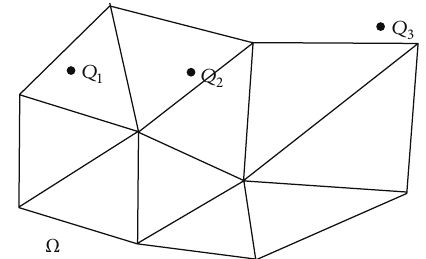
Figure 2: The exhibition of interior and exterior